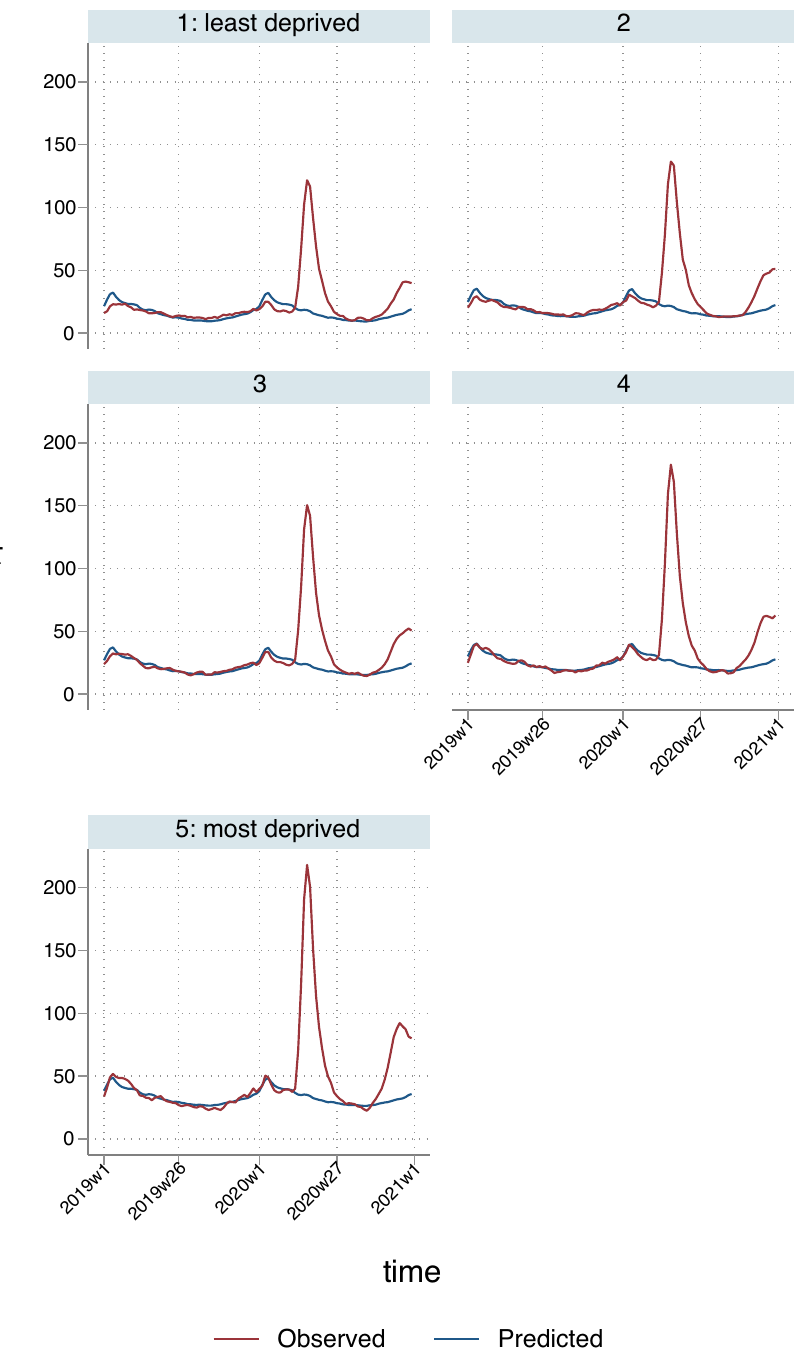
Fig 4. Temporal patterns in YLL per 100,000 population due to direct deaths, by deprivation quintile � . � 3-week smoothed. YLL, years of life lost.